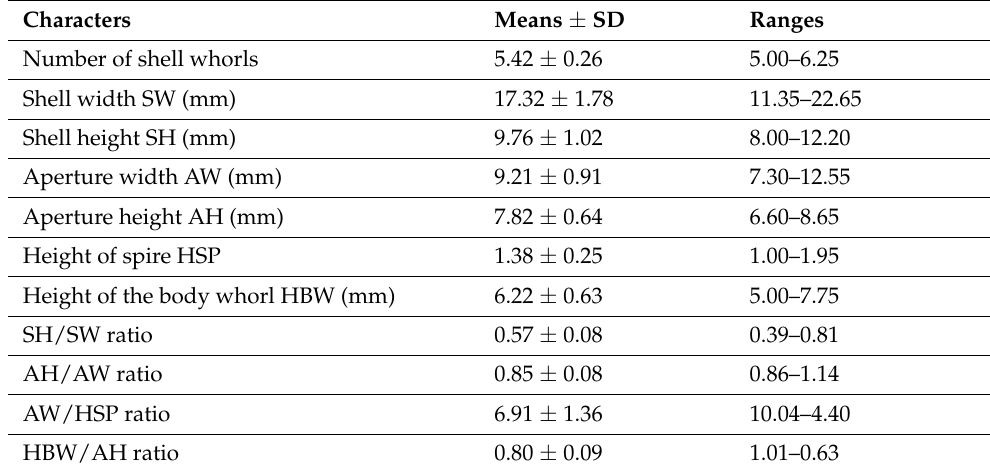
Table 3. Morphometric characteristics of Macrochlamys indica